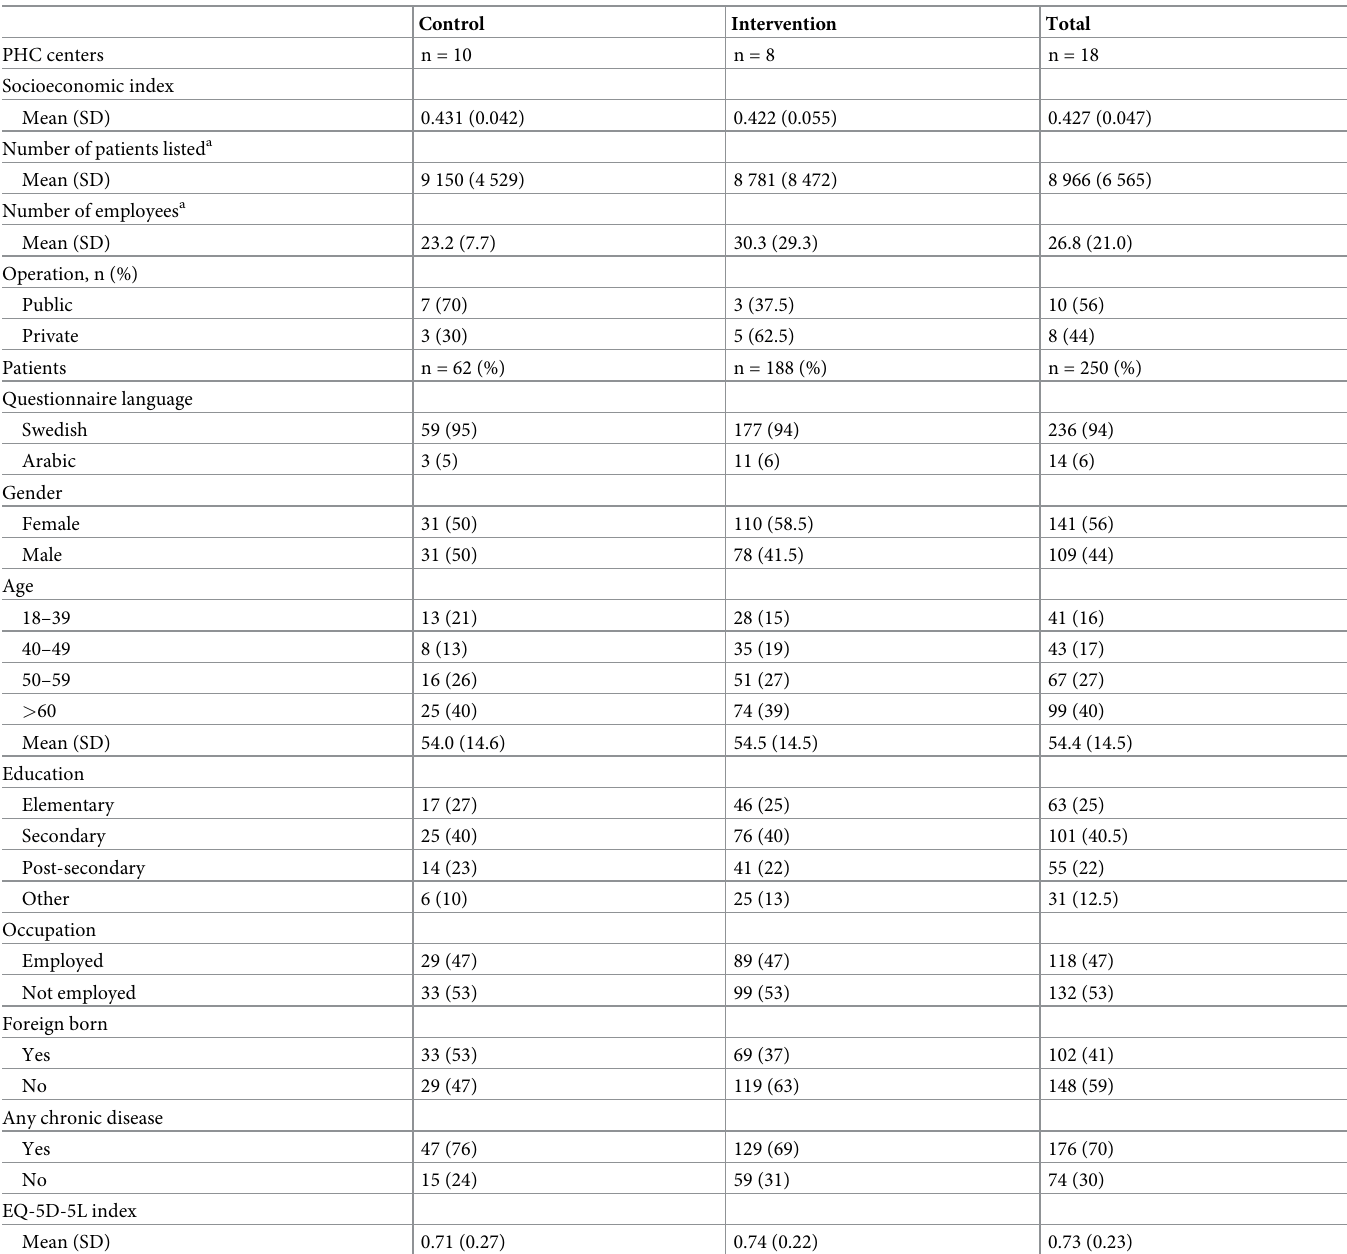
Table 1. PHC center characteristics and patient demographics at